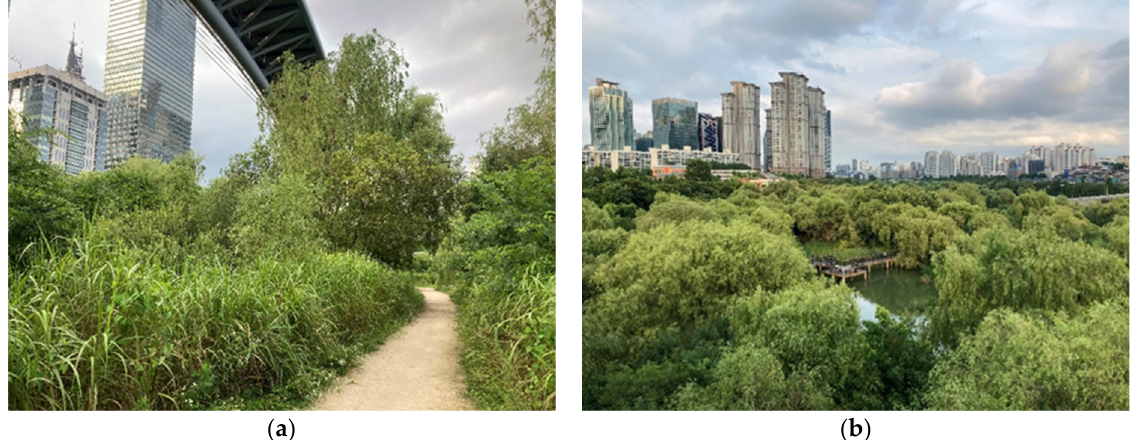
Figure 2. Saetgang ecological park: ( a ) pastoral landscape of the promenade; ( b ) a view overlooking the park. Source: Author’s photographs.